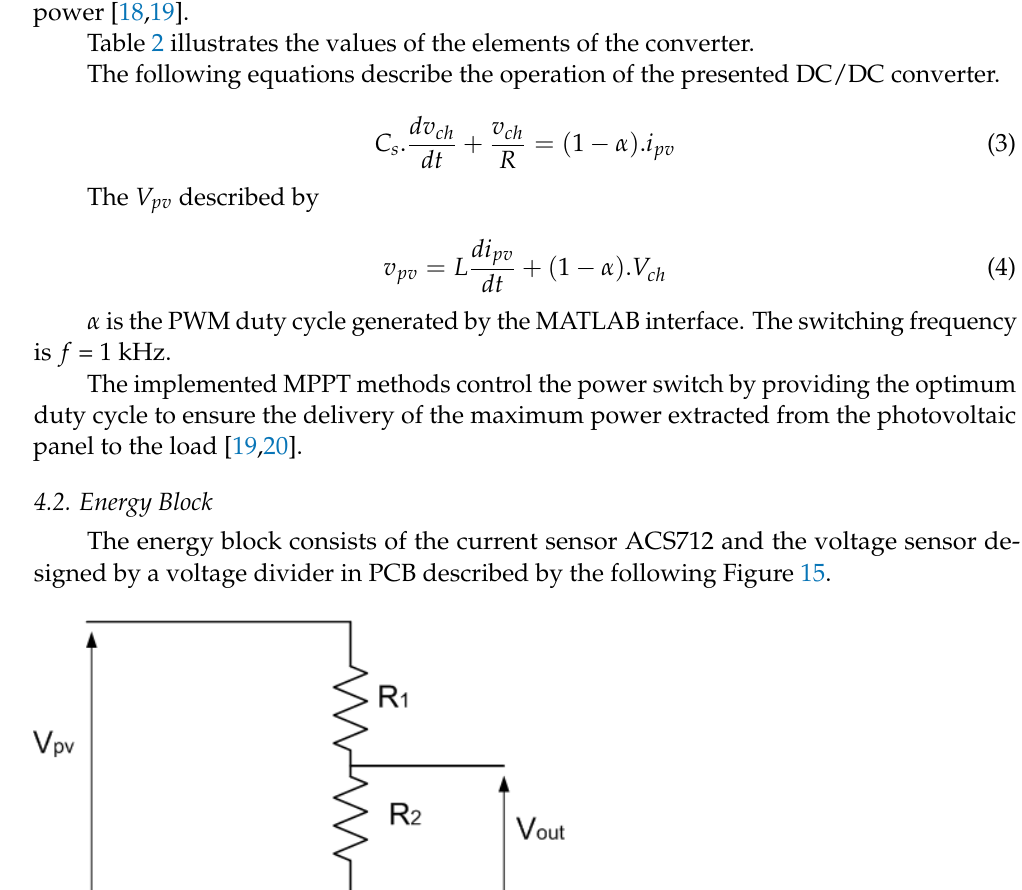
Figure 14. Synoptic of the system.